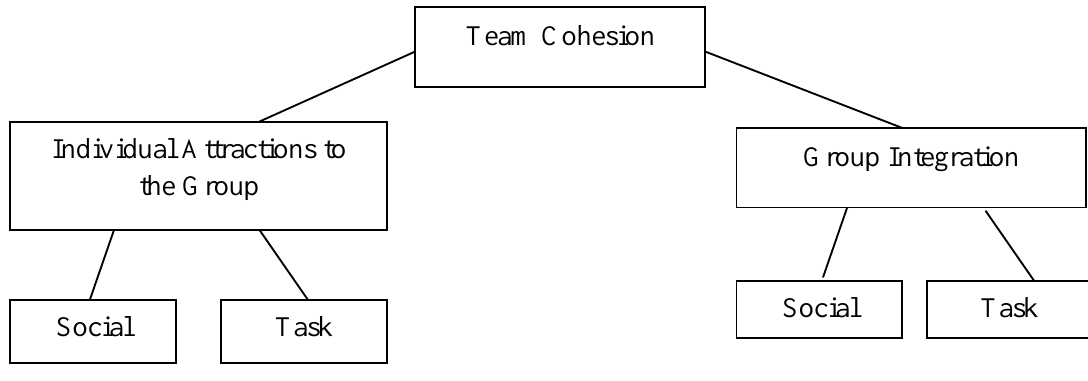
Figure 2.1 – Conceptual Model of Team Cohesion for Sports (Carron and Brawley